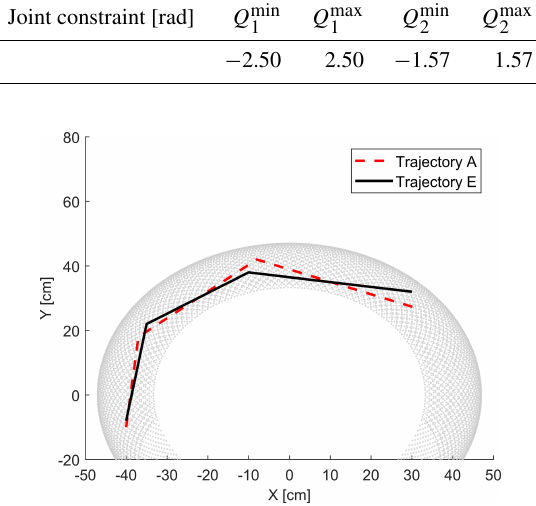
Figure 4. The grey dots represent the workspace of the robot. The dashed red and the solid black lines represent two similar desired trajectories A and E in the